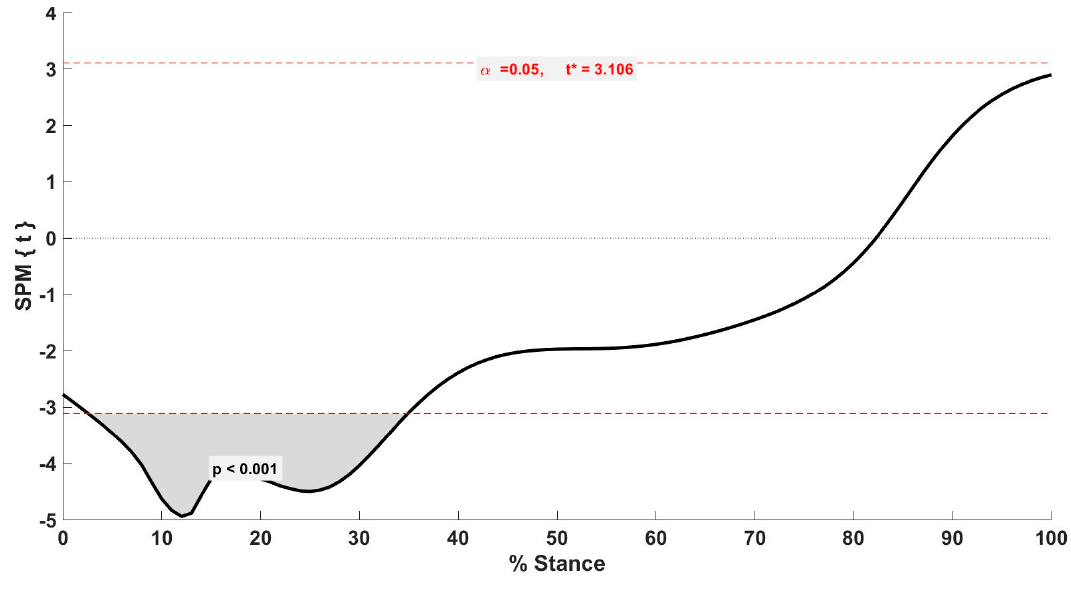
Figure 3. ( a ) Mean (solid line) and standard deviation (shaded) tibial rotation angle between preferred (black), +5% (red), and +10% (blue) step rate conditions. ( b ) t -values of SPM post hoc comparison between preferred and +10% conditions for tibial rotation angle. Dashed red lines indicate critical threshold ( α = 0.05). Gray shaded area indicates regions with statistically significant differences between the preferred and +10% condition.